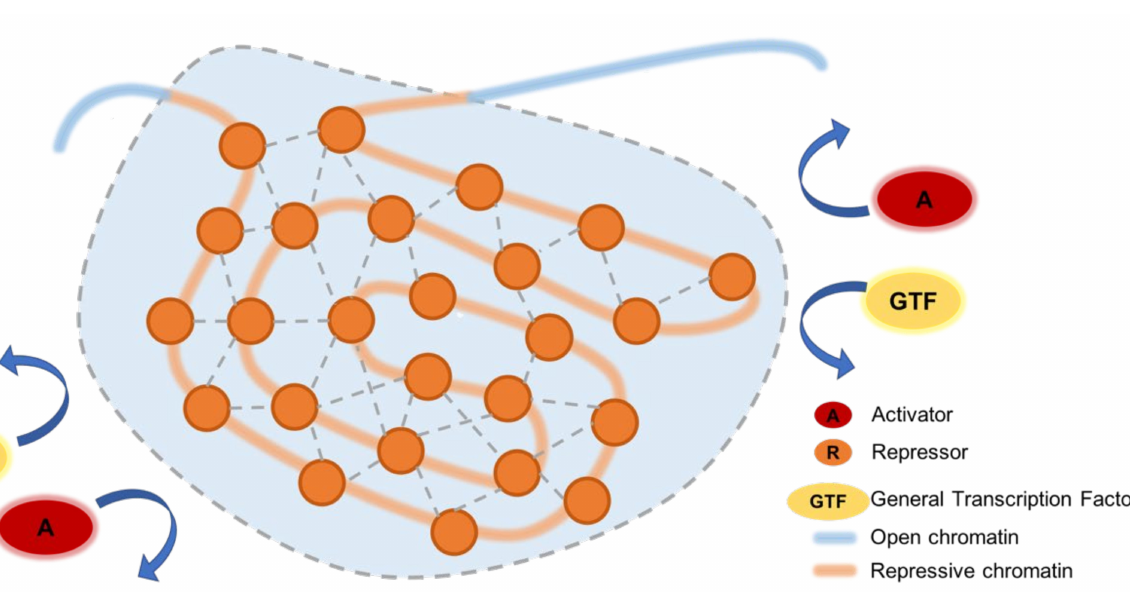
Figure 3. Phase separation in silencing. Repressors bind to heterochromatin domains and form protein–protein interactions with each other, assembling into a phase-separated condensate that selectively incorporates repressive factors and excludes transcription